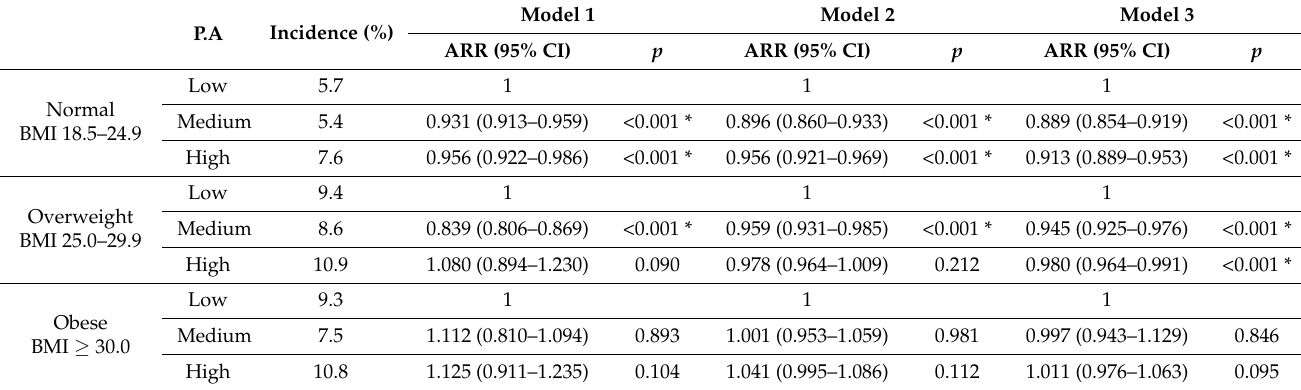
normal vs. overweight, p < 0.001 * normal vs. obese, p < 0.001 * overweight vs. obese, p = 0.007